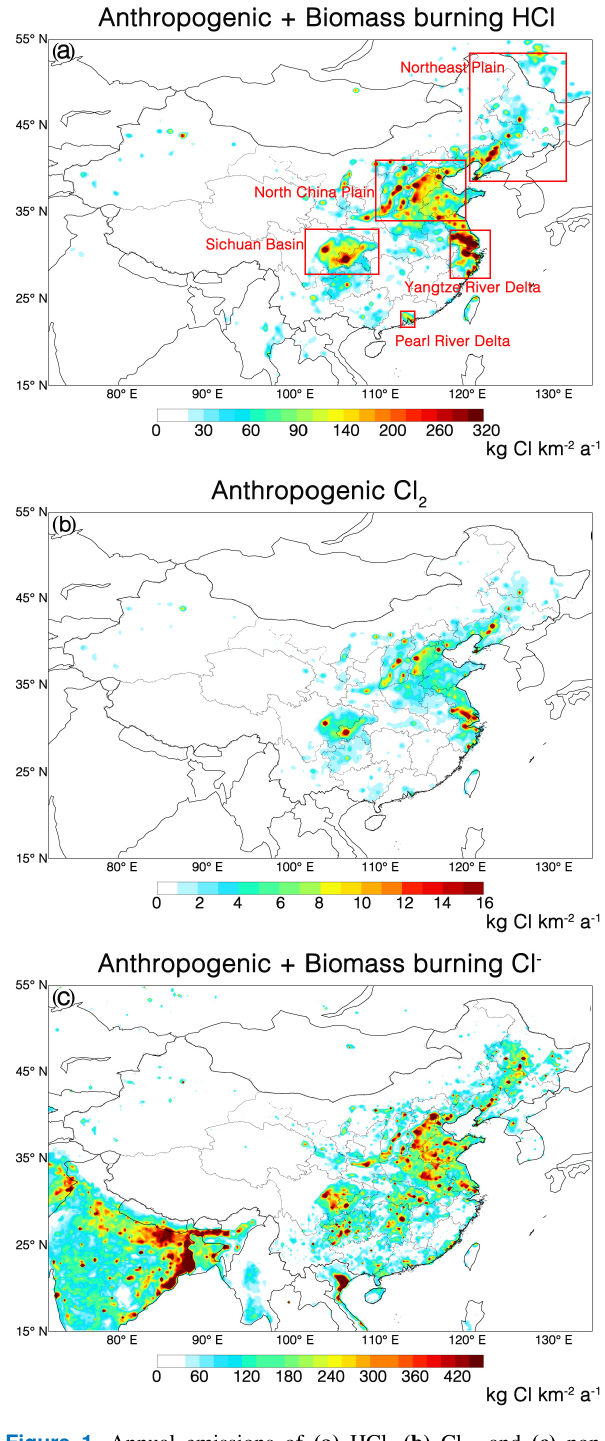
Figure 1. Annual emissions of (a) HCl, (b) Cl 2 , and (c) non- sea-salt Cl − . Locations of the Northeast Plain, North China Plain, Yangtze River Delta, Pearl River Delta, and Sichuan Basin are high- lighted by red boxes in (a)